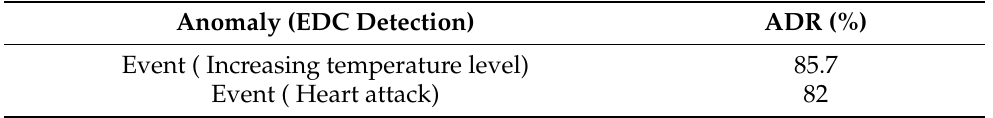
Table 4. Anomaly detection for event